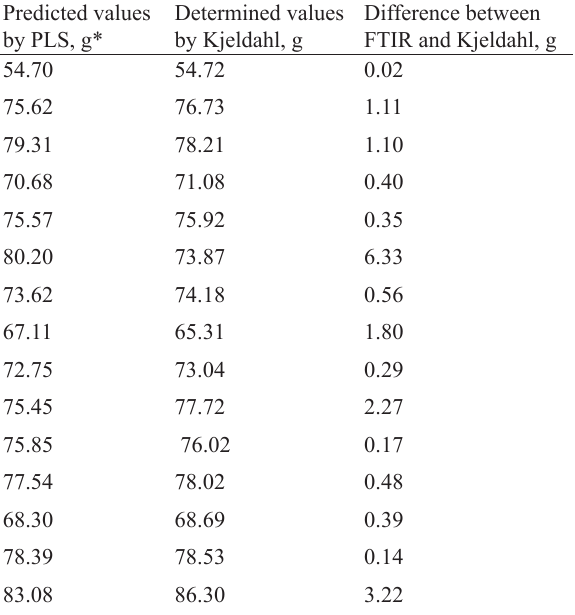
*Results for sub-region: 1160–2205 cm –1 after SNV normalization (Fig.